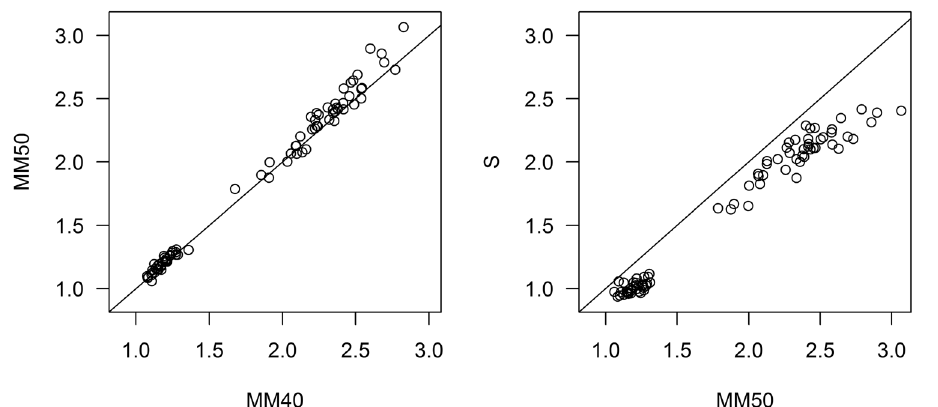
Figure 2. Scatterplots of each of the two steps in the Two-Step pathway: MM40 vs MM50 (change in acquisition), and MM50 vs S (change in method). Each plot includes a 1 = 1 line, to aid